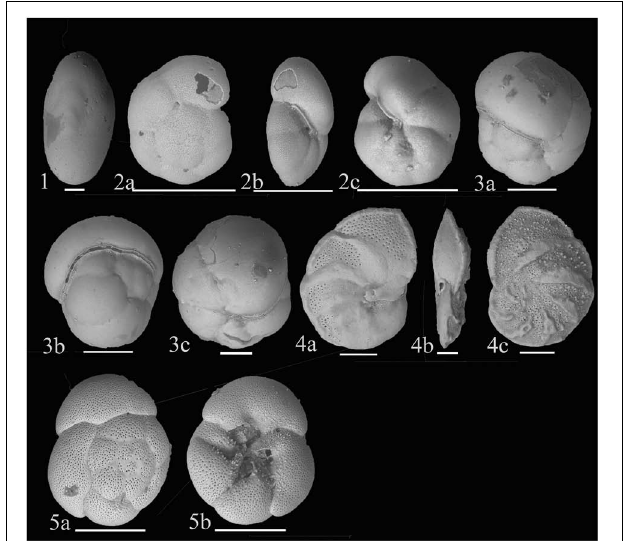
FIGURE 6 | (1) Chilostomella oolina Schwager 1878; (2) Gyroidinoides subzelandica Hornibrook, 1961; (a) Dorsal view (b) Apertural view (c) Ventral view; (3) Rotaliatinopsis semiinvoluta (Germeraad, 1946); (a,c) Side views (b) Apertural view; (4) Hanzawaia nipponica Asano, 1944; (a) Ventral view (b) Apertural view (c) Dorsal view; (5) Ammonia tepida (Cushman, 1926); (a) Dorsal view (b) Ventral view. Scale bar is 100 µ